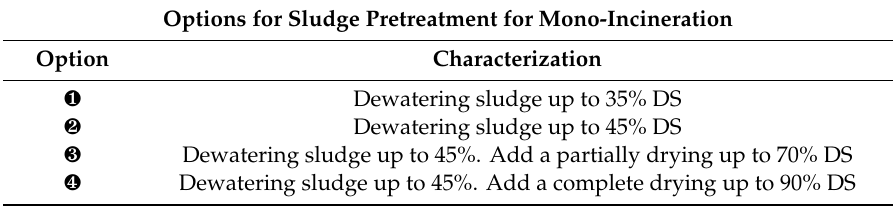
Table 1. Options for sludge pre-treatment for mono-incineration. DS: dry solids.